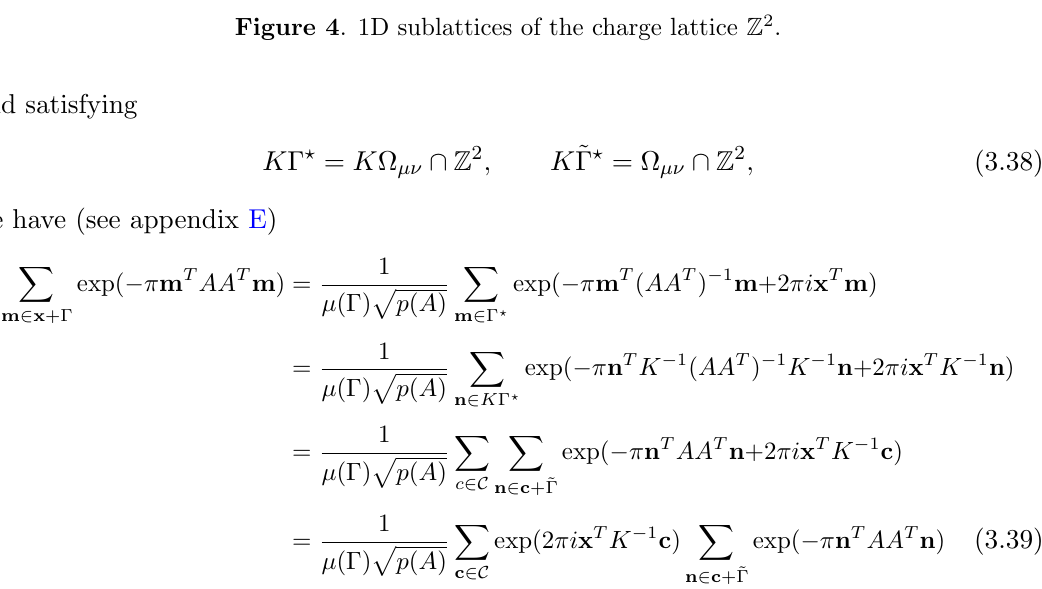
Figure 4 . 1D sublattices of the charge lattice Z 2